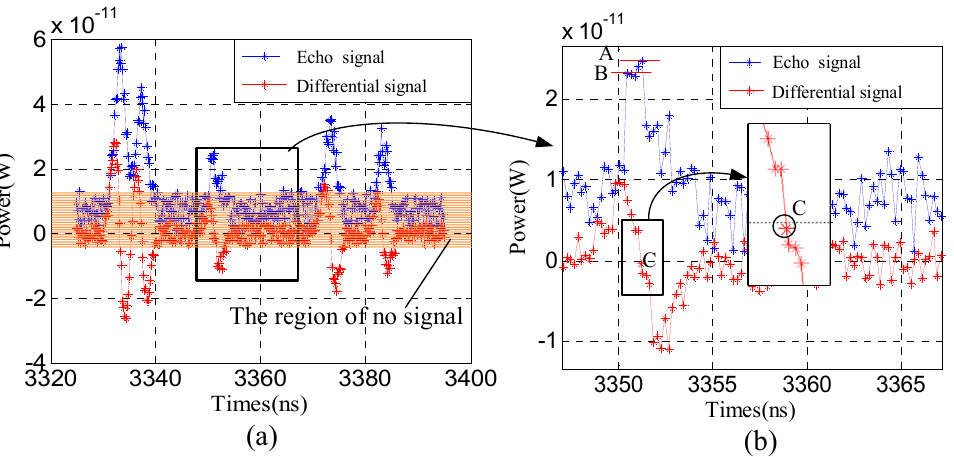
Figure 13. Example of the issue on not exact zero when taking the signal difference. ( a ) The echo signal from the depth of field of view. ( b ) Zooming area for the black rectangle of ( a ).